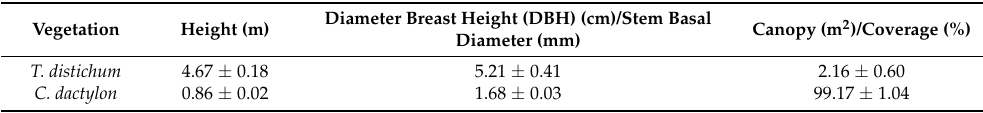
Table 1. Basic situation of the vegetation (Mean ±